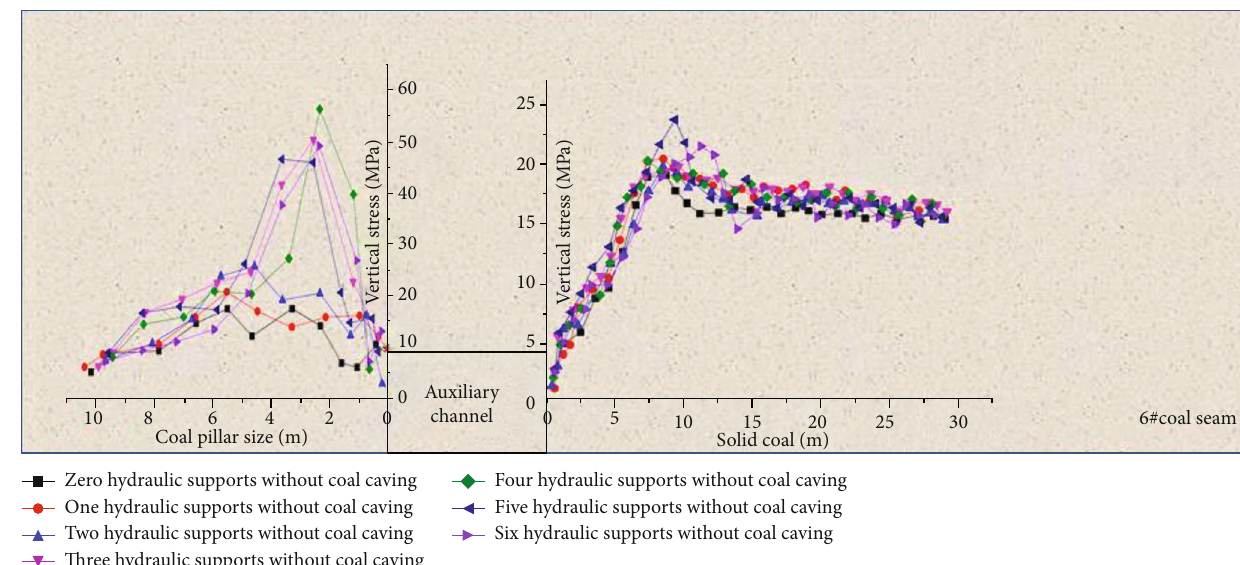
Figure 11: Change of vertical stress of solid coal on the right of coal pillar and roadway with length of end empty section (10 m coal